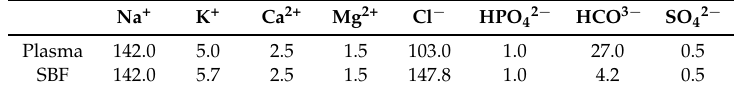
Table 1. Comparison between the composition (mM) of human plasma and simulate body fluid (SBF). Na + K + Ca 2+ Mg 2+ Cl ´ HPO 42 ´ HCO 3 ´ SO 42 ´ Plasma 142.0 5.0 2.5 1.5 103.0 1.0 27.0 0.5 SBF 142.0 5.7 2.5 1.5 147.8 1.0 4.2